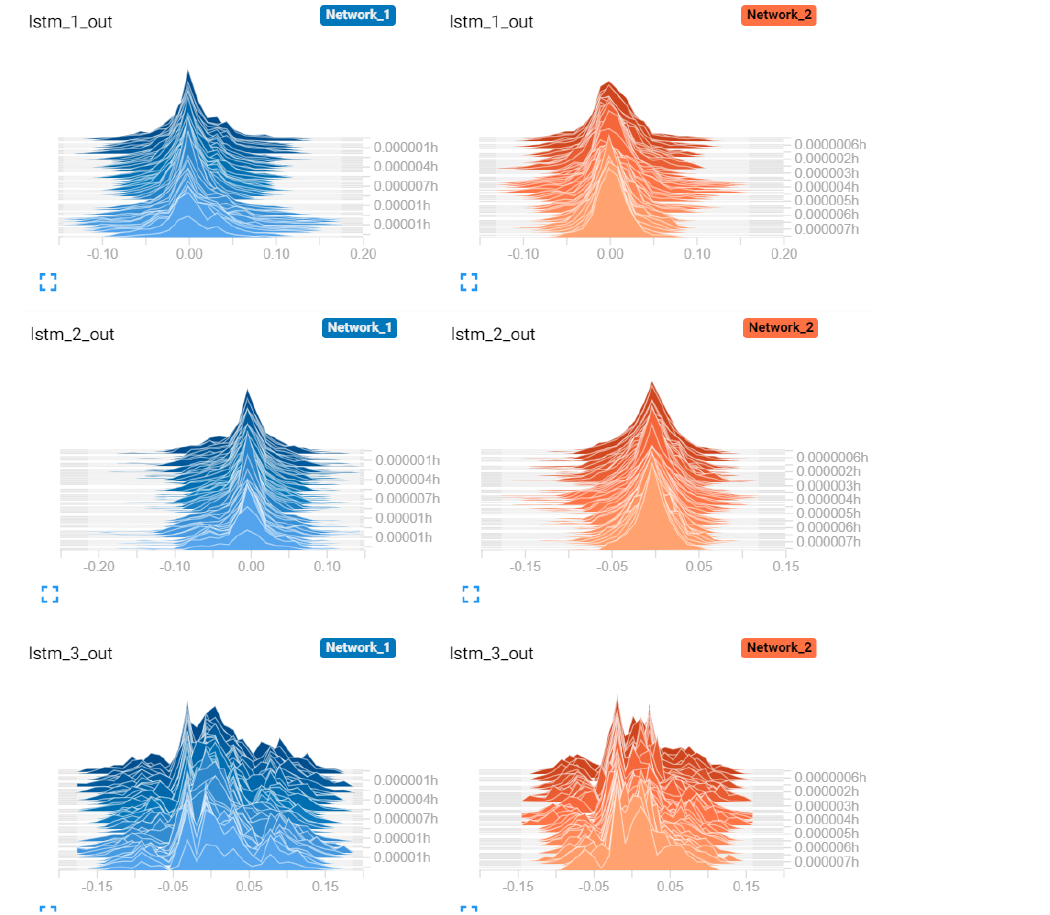
Figure 9. Distribution of the output tensors of each hidden LSTM layer for the first Network_1 and the second Network_2 LSTM networks, visualized via TensorBoard. Each slice displays a single histogram updated at each iteration. The “oldest” iterations are further back and darker, while the “newer” ones are lighter and closer to the front. The y axis indicates the relative time of each update.